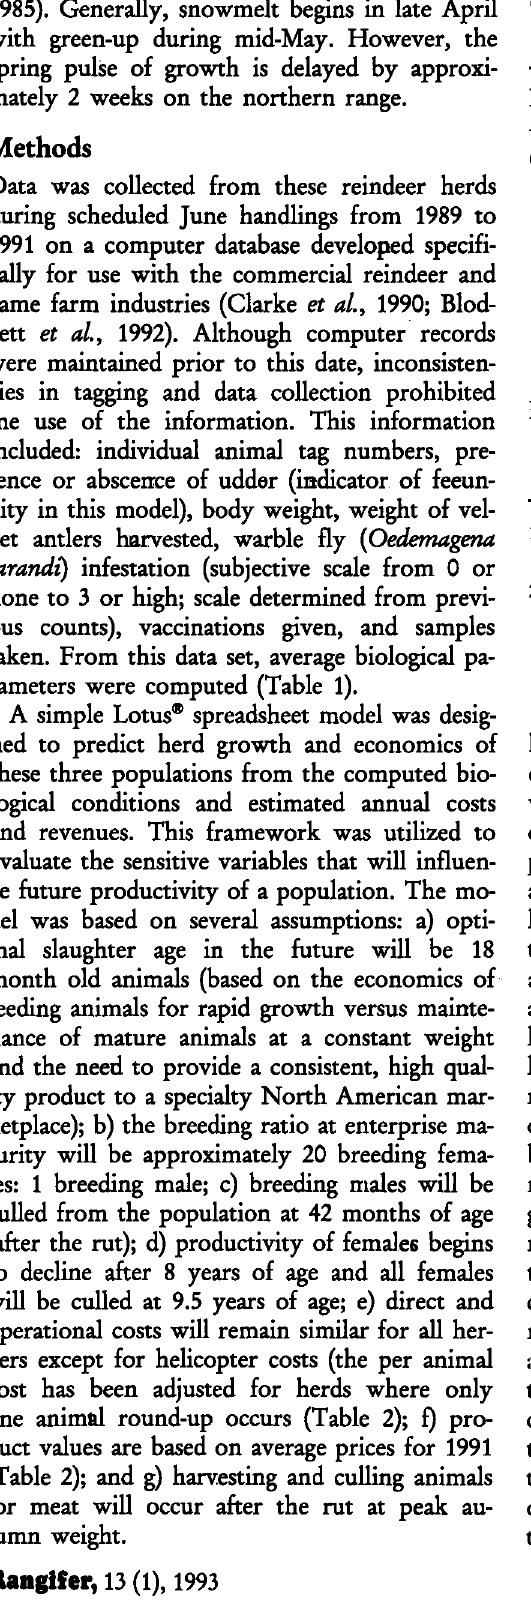
Table 2. Annual costs and revenues required by an extensive reindeer